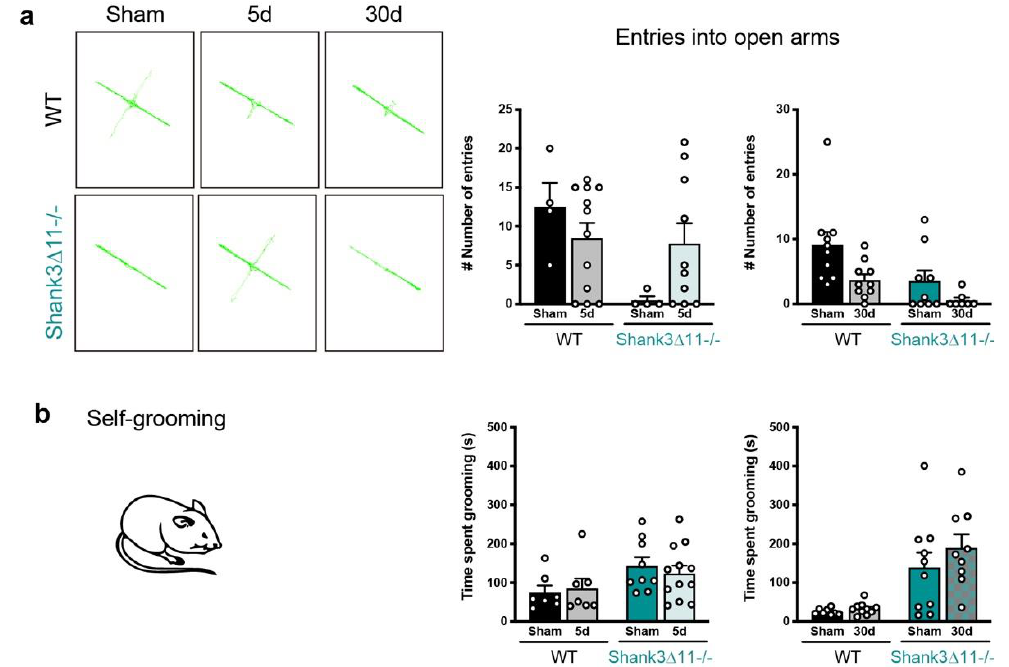
Figure 6. Wild-type animals show no anxiety-like behavior after mTBI, while repetitive behaviors are not exacerbated in Shank3 ∆ 11 − / − following mTBI. ( a ) Anxiety assessment through the elevated plus maze (EPM) after 5 d and 30 d of mTBI. Representative tracking images of WT mice trajectory (left upper panel) compared to Shank3 ∆ 11 − / − animals (left bottom panel) on the EPM. Quantification of the number of entries into the open arms of the EPM (right panel) of WT (black bars) and Shank3 ∆ 11-/- (turquoise bars). N = 4 – 12, data are shown as mean ± SEM. Datasets were analyzed using two-way ANOVA (genotype × mTBI intervention), and Bonferroni’s post hoc comparison test was performed. [Entries into the open arm at 5 d: genotype F(1, 26) = 5.074, p = 0.0330; mTBI inter- vention F(1, 26) = 0.3374, p = 0.5664; interaction genotype × mTBI F(1, 26) = 3.990, p = 0.0563. Entries into the open arm at 30 d: genotype F(1, 32) = 8.457, p = 0.0066; mTBI intervention F(1, 32) = 7.903, p = 0.0084; interaction genotype × mTBI F(1, 32) = 0.6562, p = 0.4239]. ( b ) The time spent performing self-grooming was quantified during 20 min in WT (black bars) compared to Shank3 ∆ 11-/- (turquoise bars) mice after 5 d and 30 d of mTBI. N = 7 – 12. Data are shown as mean ± SEM. Datasets were analyzed using two-way AN OVA (genotype × mTBI intervention), and Bonferroni’s post hoc com- parison test was performed. [Self-grooming at 5 d: genotype F(1, 31) = 5.651, p = 0.0238; mTBI inter- vention F(1, 31) = 0.04366, p = 0.8359; interaction genotype × mTBI F(1, 31) = 0.4236, p = 0.5199. Self- grooming at 30 d: genotype F(1, 33) = 25.46, p < 0.0001; mTBI intervention F(1, 33) = 1.182, p = 0.2849; interaction genotype × mTBI F(1, 33) = 0.6416, p = 0.4288].